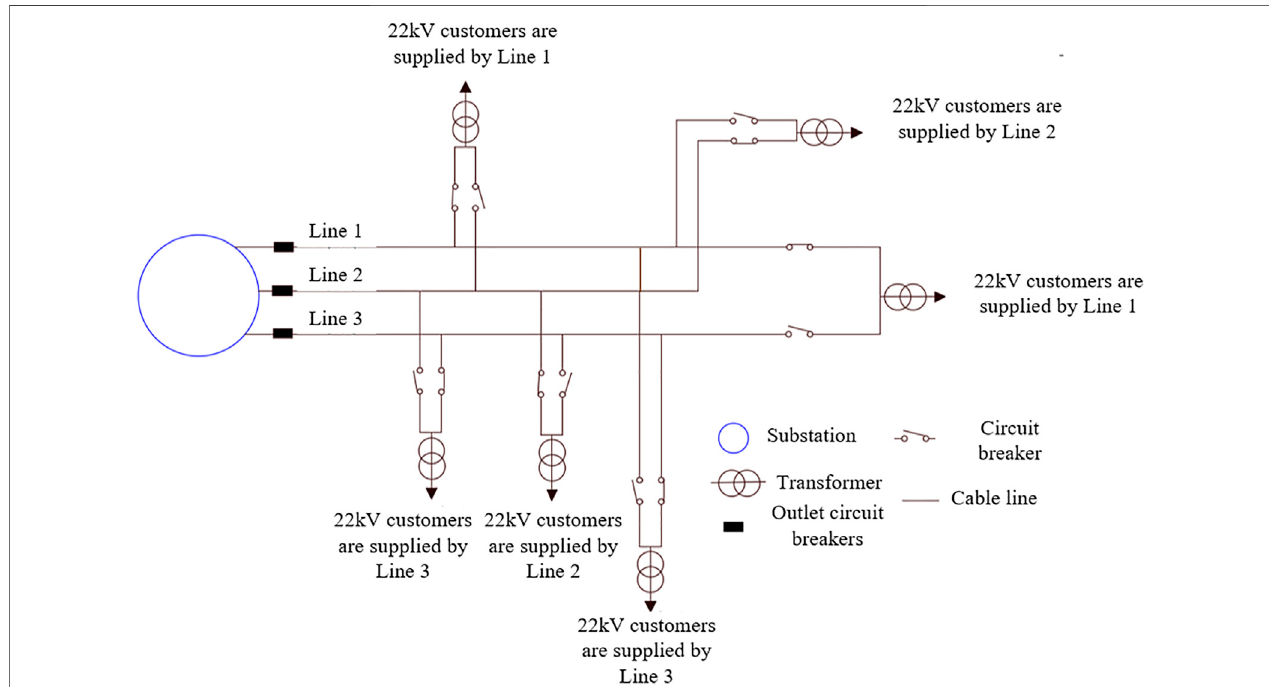
FIGURE 1 | Tokyo 22 kV cable three-shot wiring